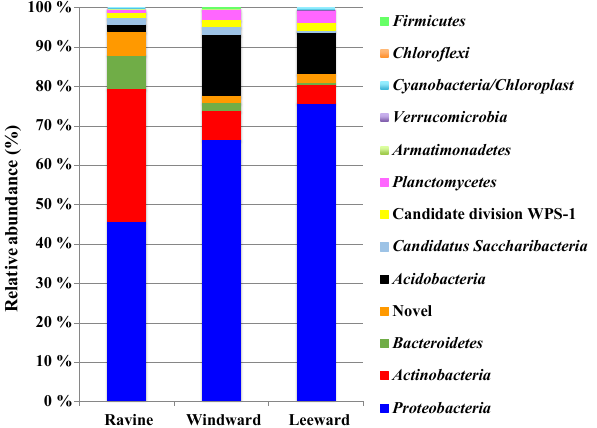
Figure 3. Microbial community structure in the three habitats of Nanjenshan Reserve. Bacterial lineages were indicated by phylum.